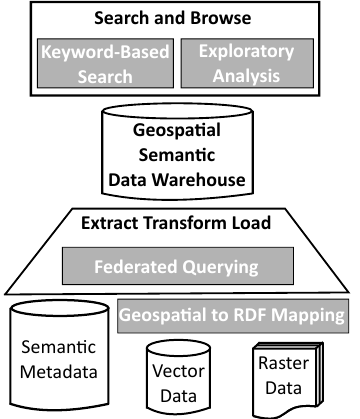
Figure 11. Illustration of challenges towards smart geospatial searching and